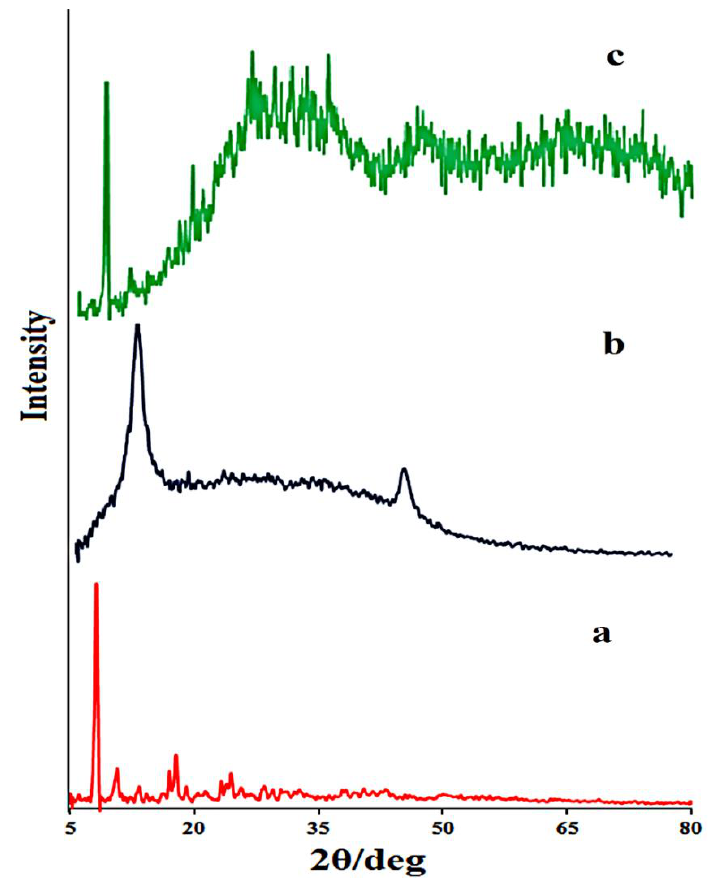
Figure 1. XRD patterns of the ( a ) CoMOF, ( b ) GO, and ( c ) CoMOF/GO